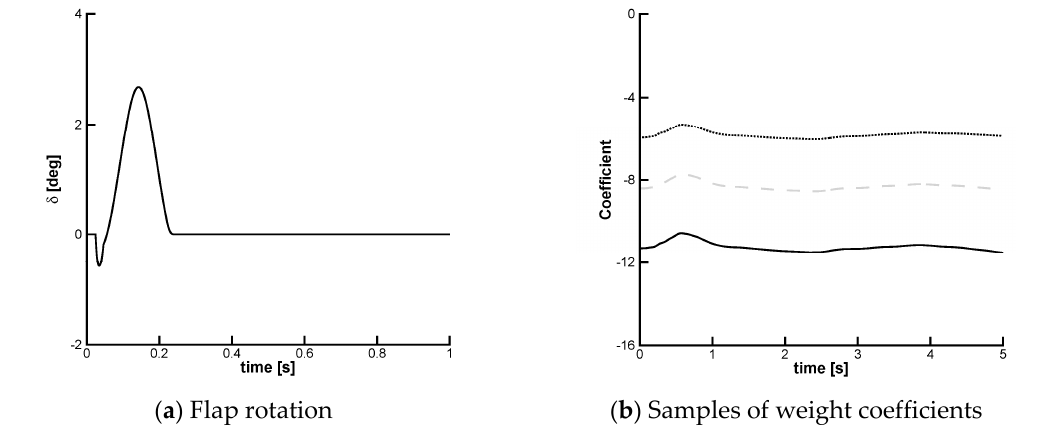
Figure 11. Aeroelastic response with control corresponding to Figure 10: ( a ) Commanded rotation of the trailing-edge flap; ( b ) Three samples (out of 20) of the weight coefficients of the controller.